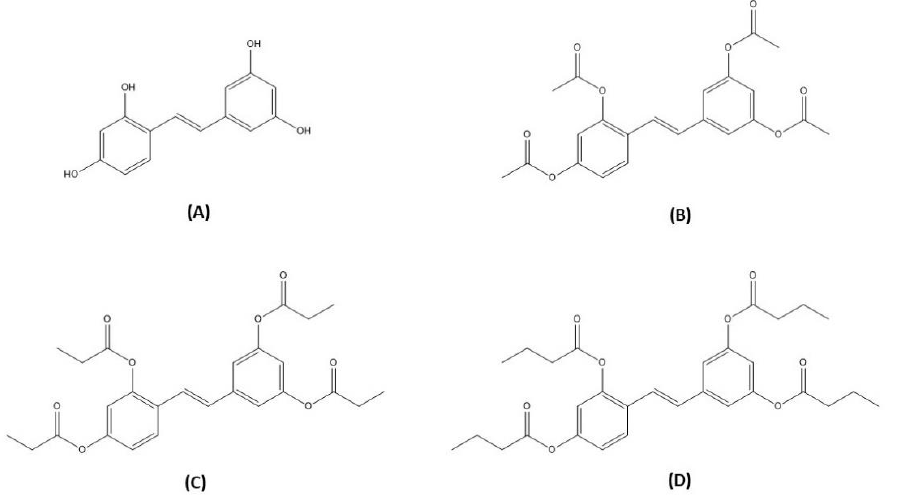
Figure 1. Structures of Oxyresveratrol (OXY; ( A )), oxyresveratrol tetraacetate (OXY-Tac; ( B )), Oxyresveratrol tetrapropionate (OXY-TPr; ( C )), and oxyresveratrol tetrabutyrate (OXY-TBu; ( D )).